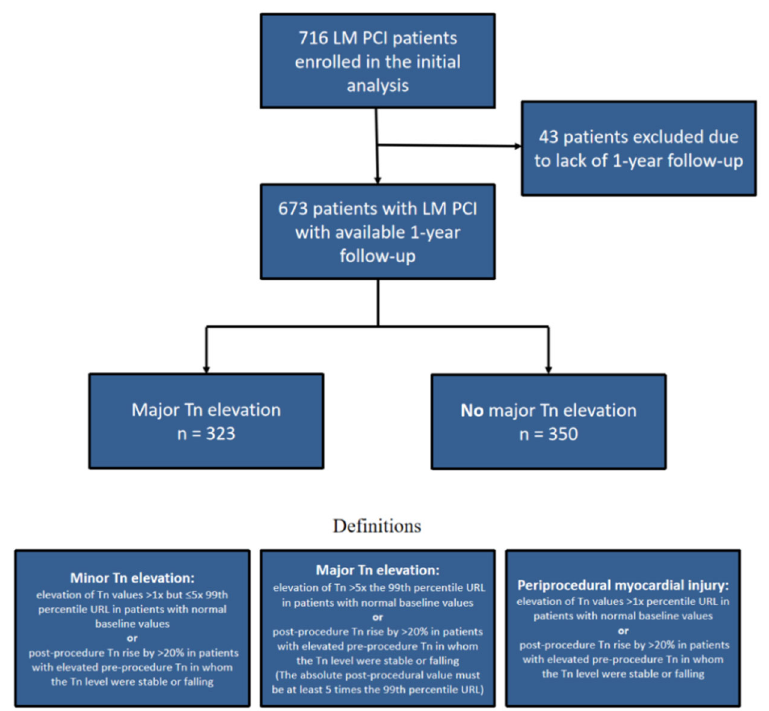
Figure 1. Flowchart presenting population size and definitions.